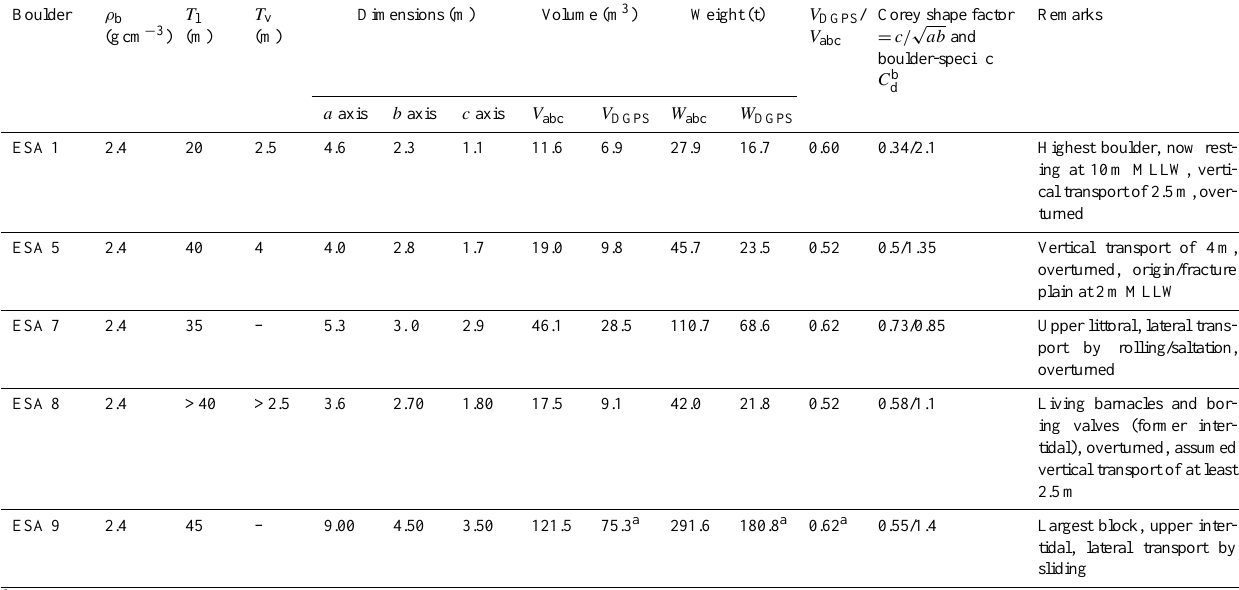
Table 2. Boulder axes, volume, and weight of most important clasts at site ESA, Eastern Samar. T l : lateral transport; T v : vertical transport; ρ b : bulk